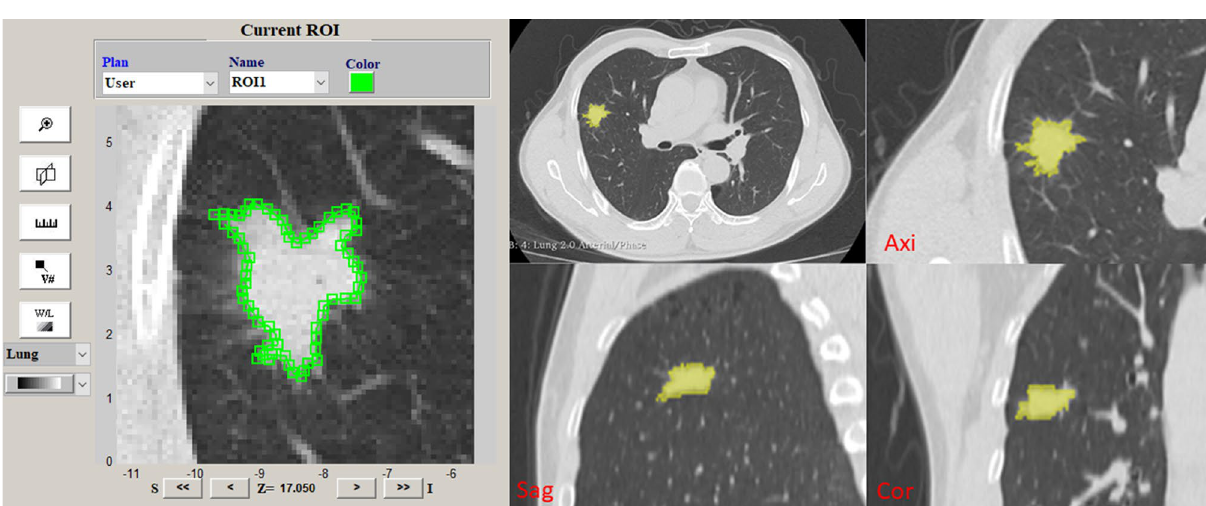
Figure 2. Image segmentation diagram. Nodule segmentation: in the image of the set window level and window width bar, the anchor points of the segmentation line is set continuously along the junction of nodule and lung. The anchor size is the default of the software, and there is no interval between the anchor